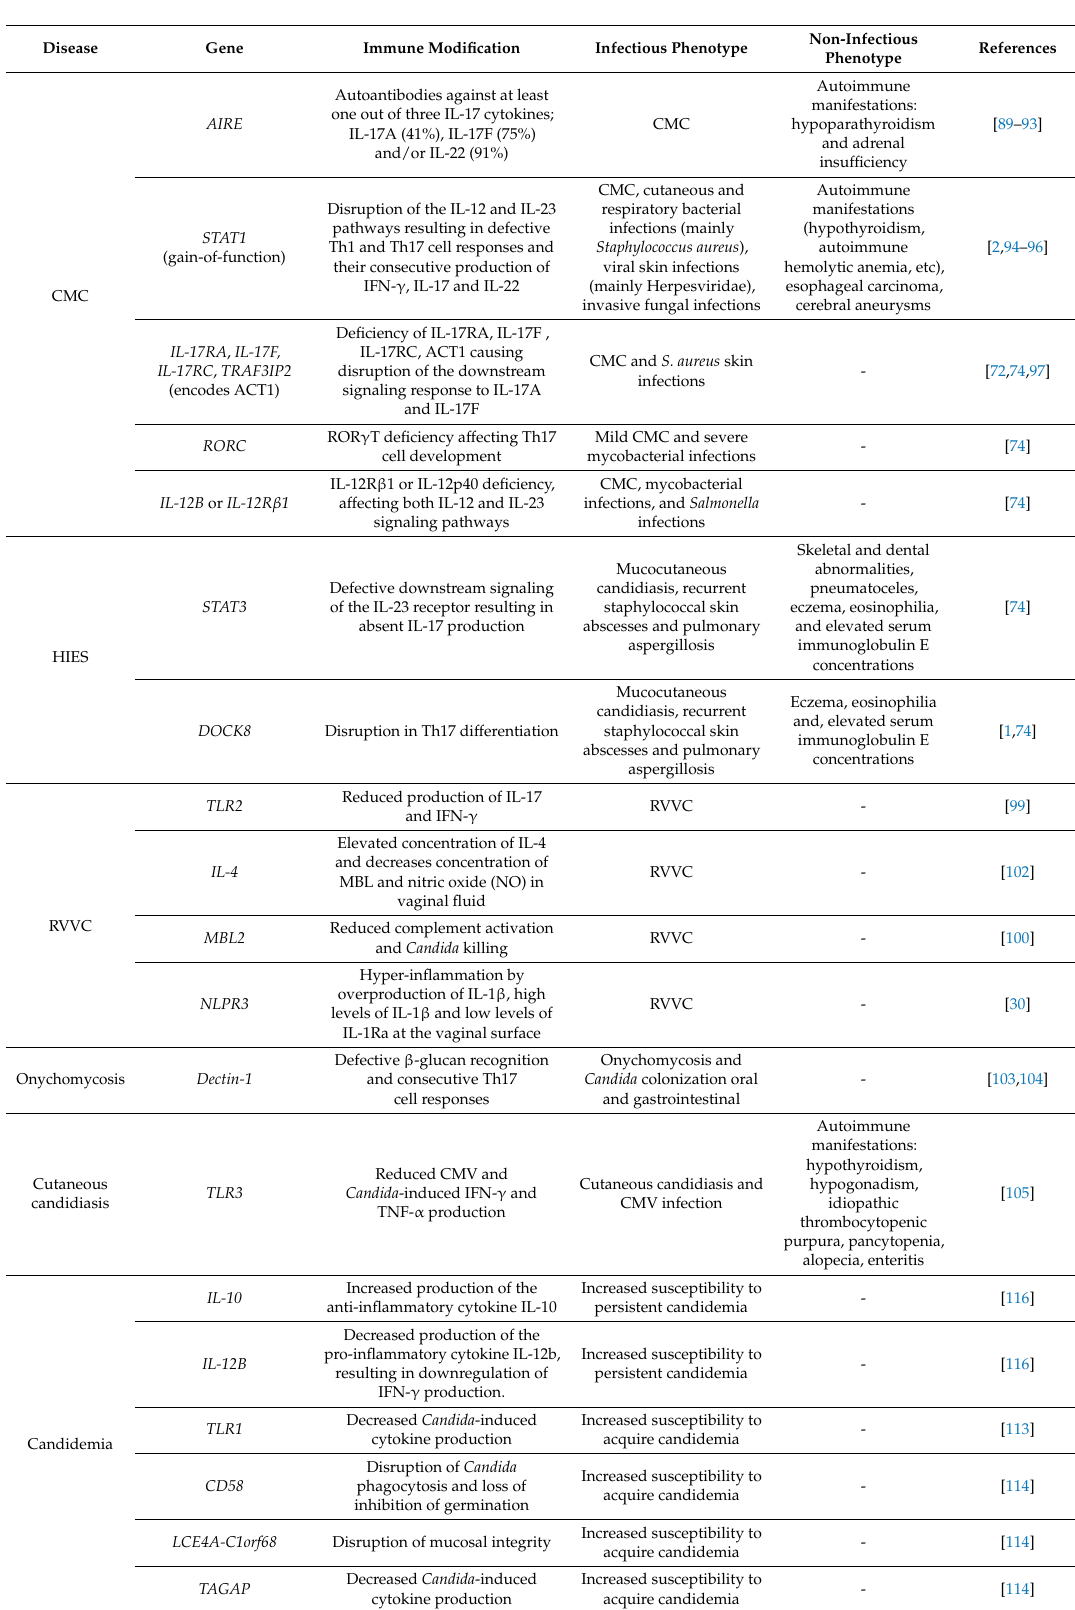
Table 1. Genes involved in genetic susceptibility to Candida